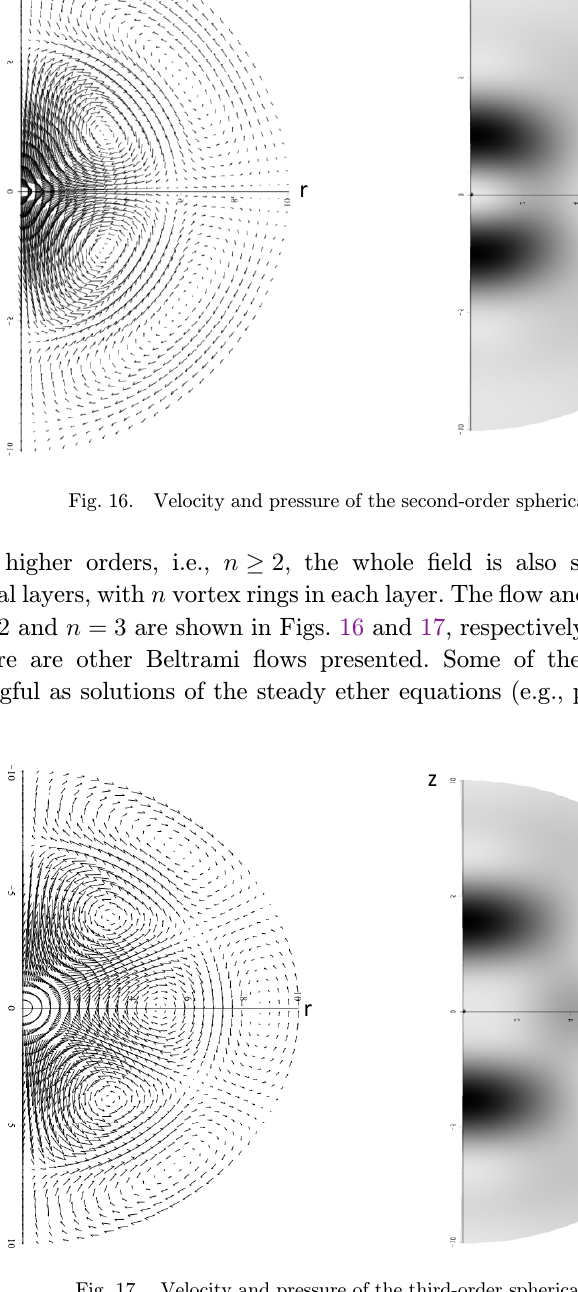
Fig. 17. Velocity and pressure of the third-order spherical solution.